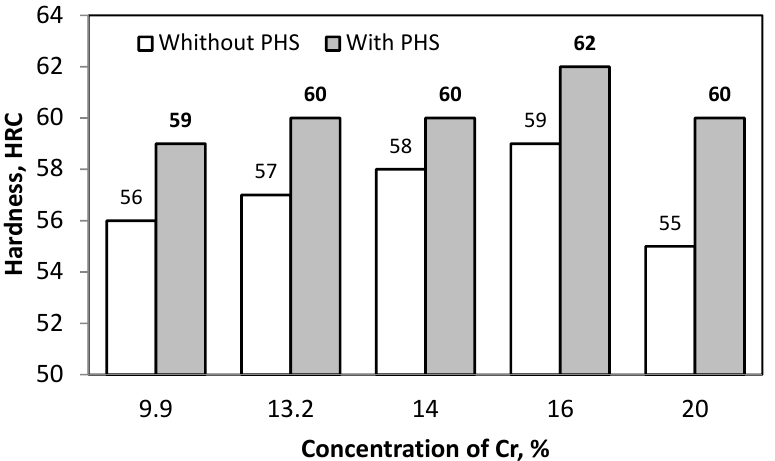
Figure 13. Diagram of the influence of Cr concentration on the hardness of the tested coatings. Figure 14 illustrates the diagram of the interconnection between the abrasive wear resistance and the hardness of the tested coatings.